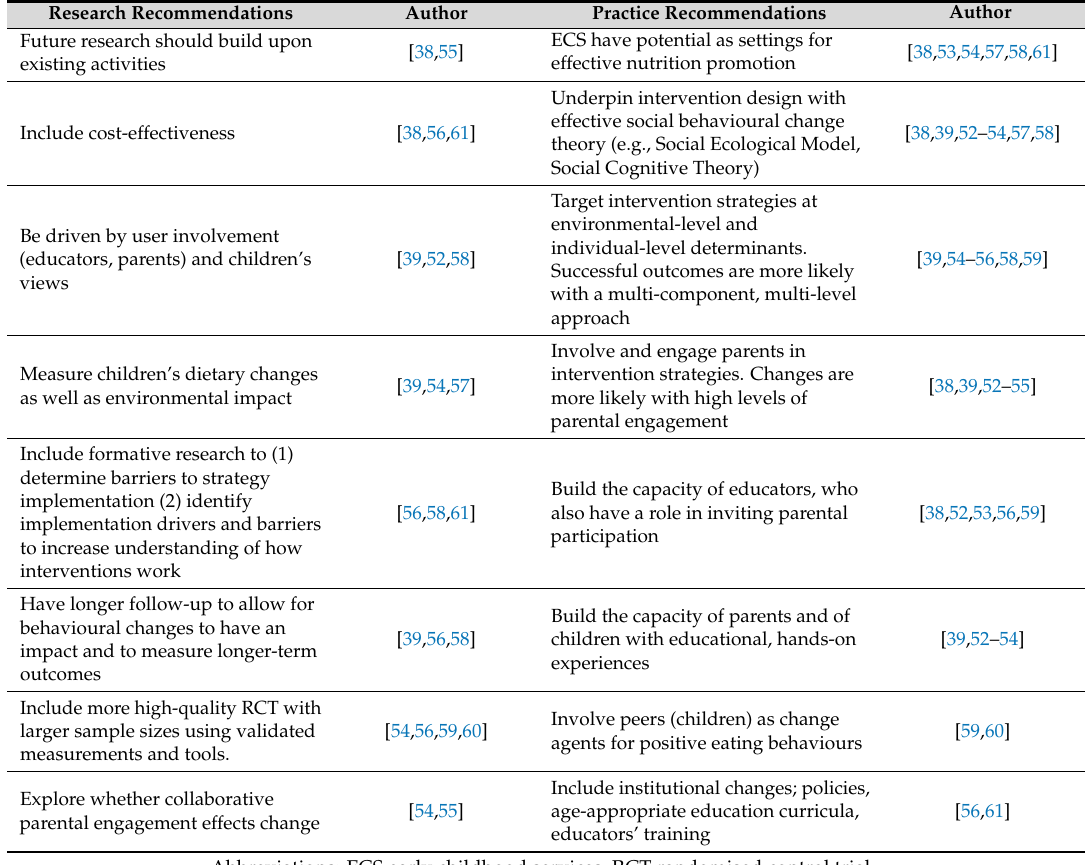
Abbreviations: ECS early childhood services, RCT randomised control